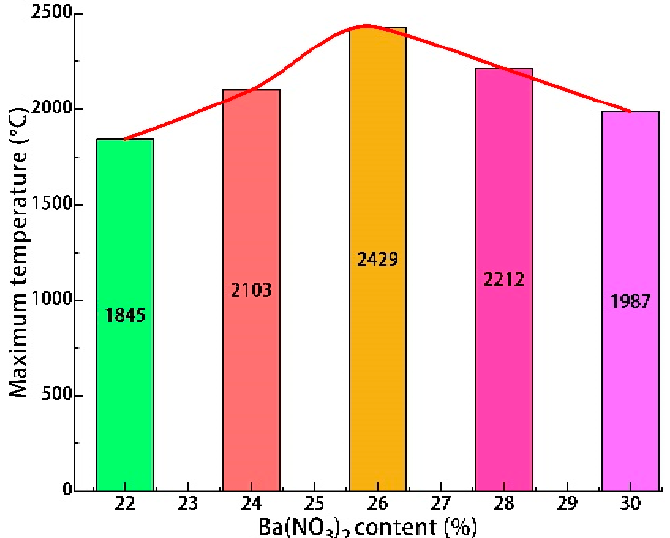
Figure 5. Effect of Ba(NO 3 ) 2 content on maximum temperature.